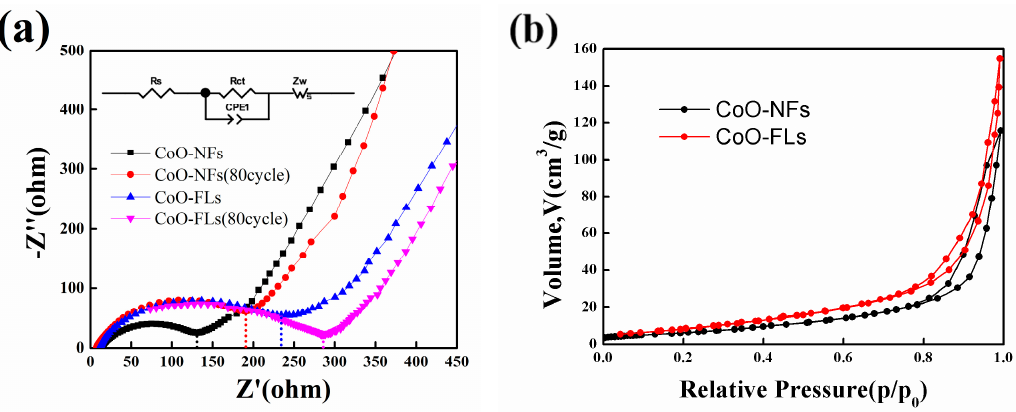
Figure 6. Electrochemical impedance spectra ( a ) and the N2 adsorption/desorption isotherms ( b ) of CoO-NFs and CoO-FLs.